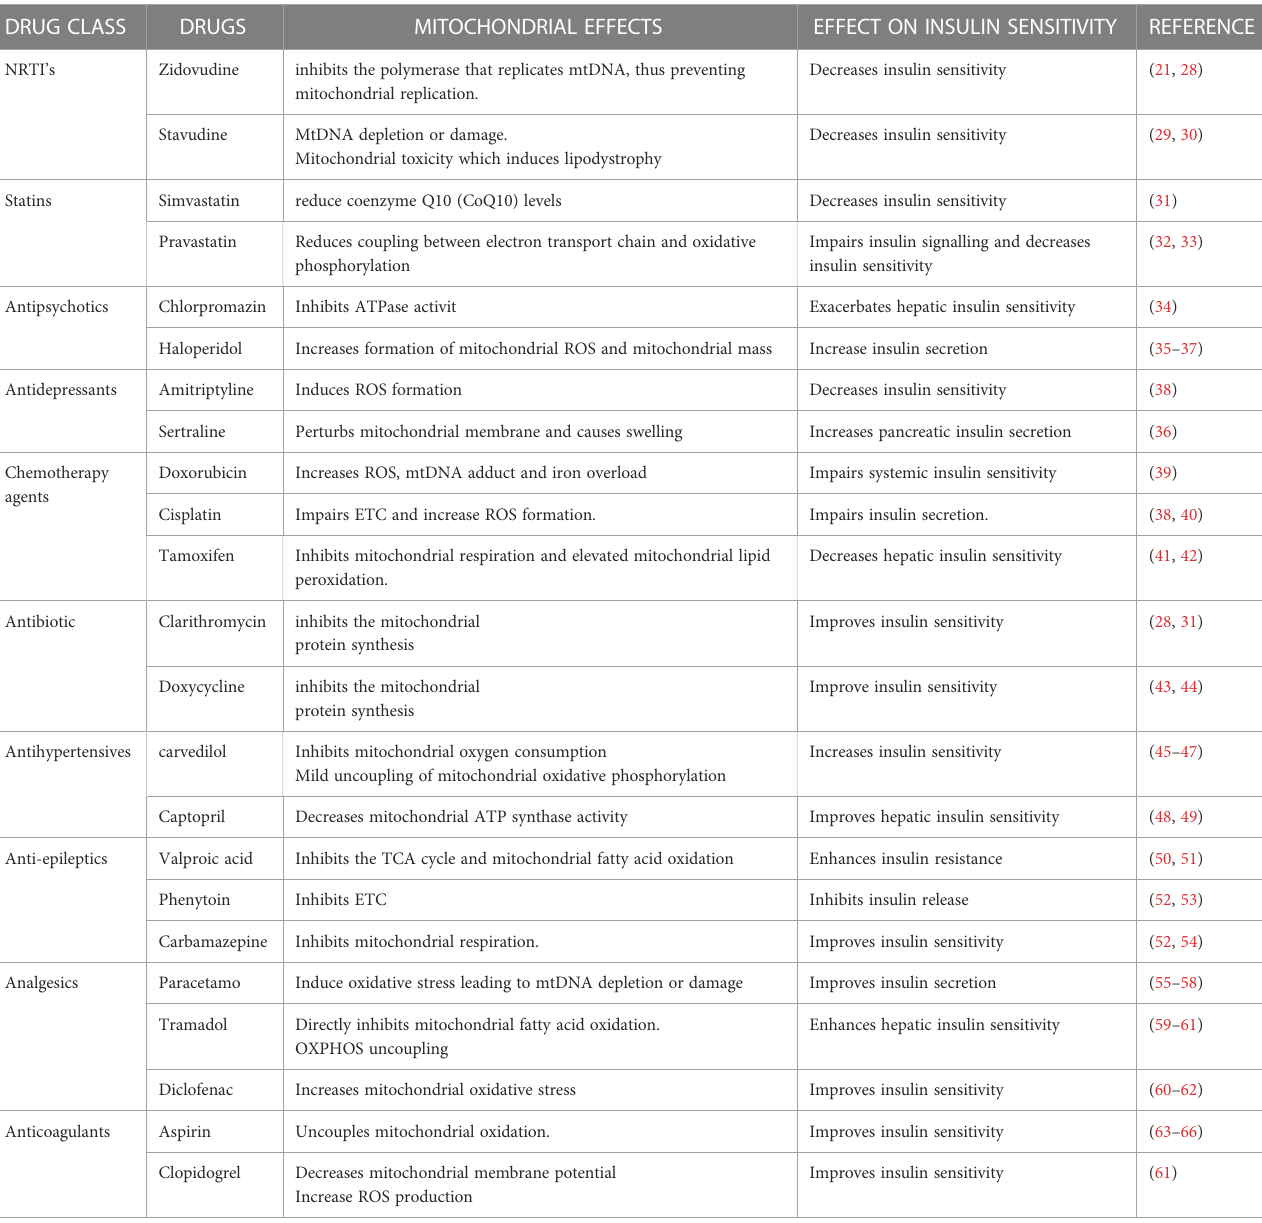
TABLE 1 Summarizes the impact of known mitotoxic agents on insulin sensitivity